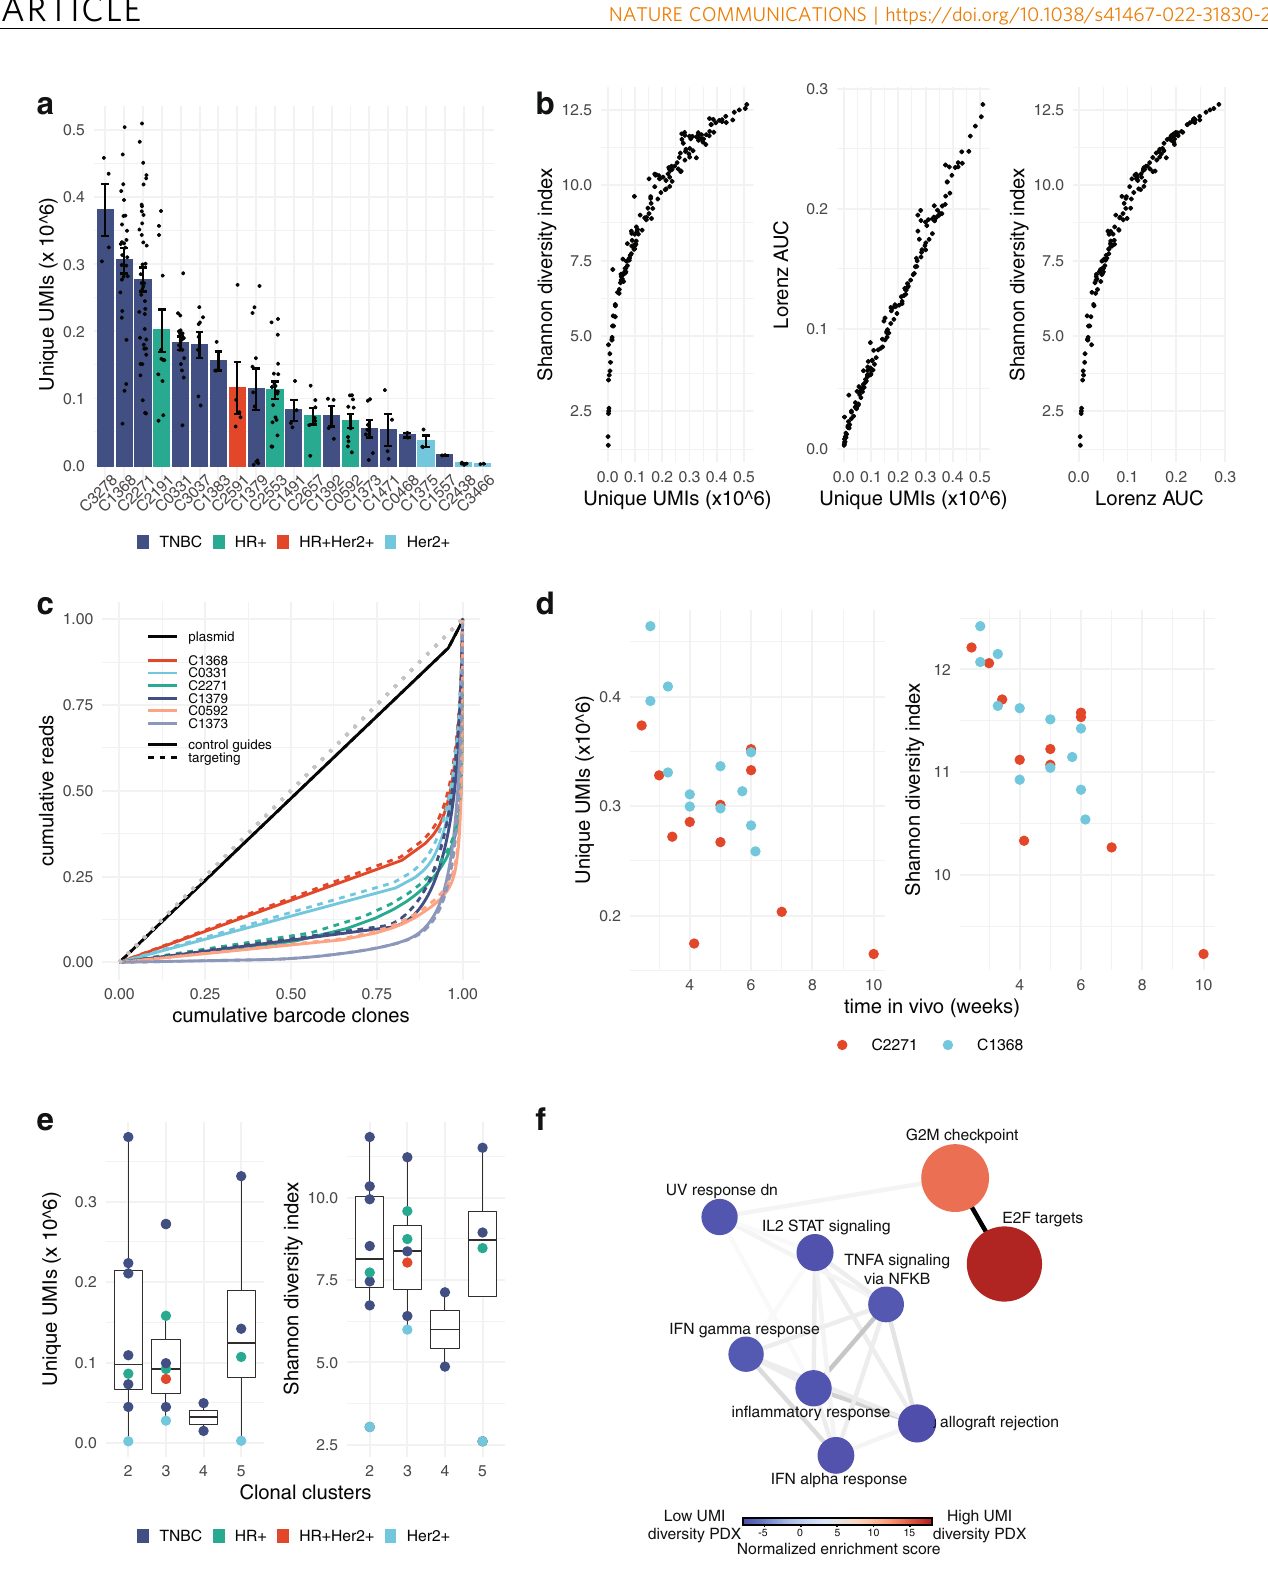
that 10 5 sgRNA-UMIs per 10 6 reads) in the three hormone receptor negative Her2 positive lines (Fig. 2a). We reasoned that low sgRNA-UMI clone number in certain PDX lines could re fl ect heavy-tailed clone size distributions, with sizeable proportions of total tumour cell mass represented by small proportions of transplant clones. We therefore compared sgRNA-UMI clone number with two different measures of diversity; Shannon diversity index (SDI), a composite entropy